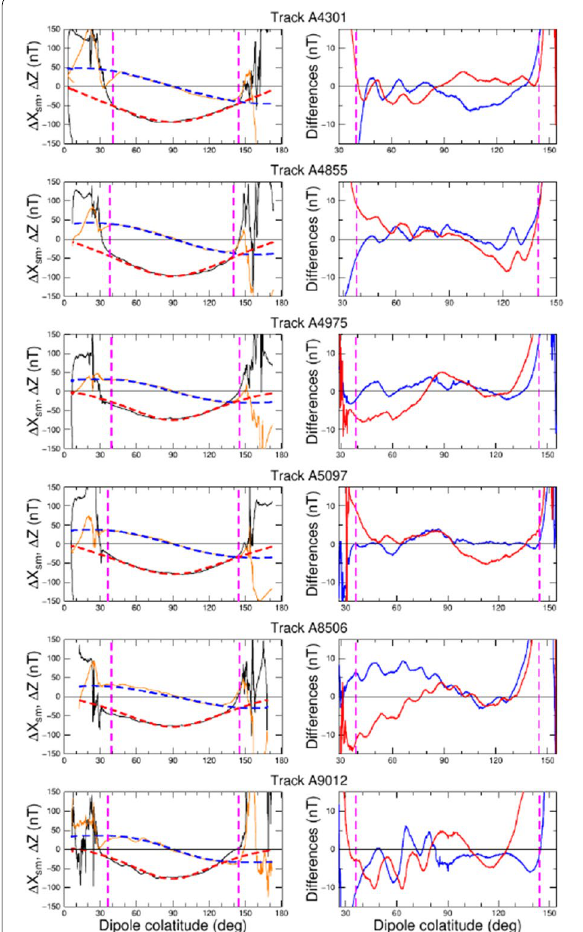
Fig. 4 Left panels: The Swarm residuals (cid:31) X sm (thin black) and (cid:31) Z (thin orange) along six Swarm A nightside full tracks (see Table 1) and best-fitting signals X ( 1 ) sm,MMC (dashed red) and Z ( 1 ) MMC (dashed blue) over the mid-latitude interval I 10 ◦ (vertical dashed violet lines) ML due the two-circular loop model of MRCs and MICs. Right panels: The differences � X sm − X ( 1 ) sm,MMC (red) and � Z − Z ( 1 ) MMC (blue) over = (ϑ + 10 ◦ , ϑ − 10 ◦ ) , mid-latitude interval I 10 ◦ . Here, I 10 ◦ sm,R n 2 sm,R s 2 ML ML and ϑ sm,R n and ϑ sm,R s are dipole colatitudes of equatorward Region 2 2 2 of the northern and southern auroral ovals,